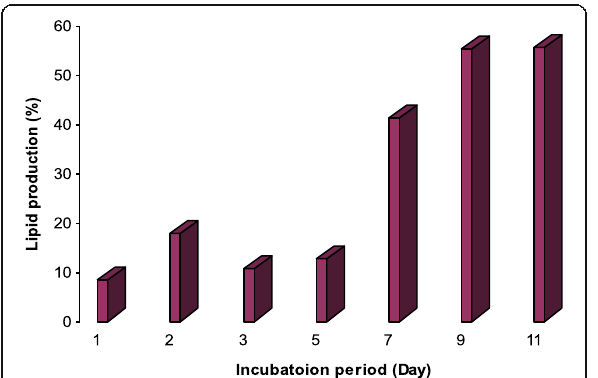
Fig. 5 Effect of incubation period on F. oxysporum NRC 2017